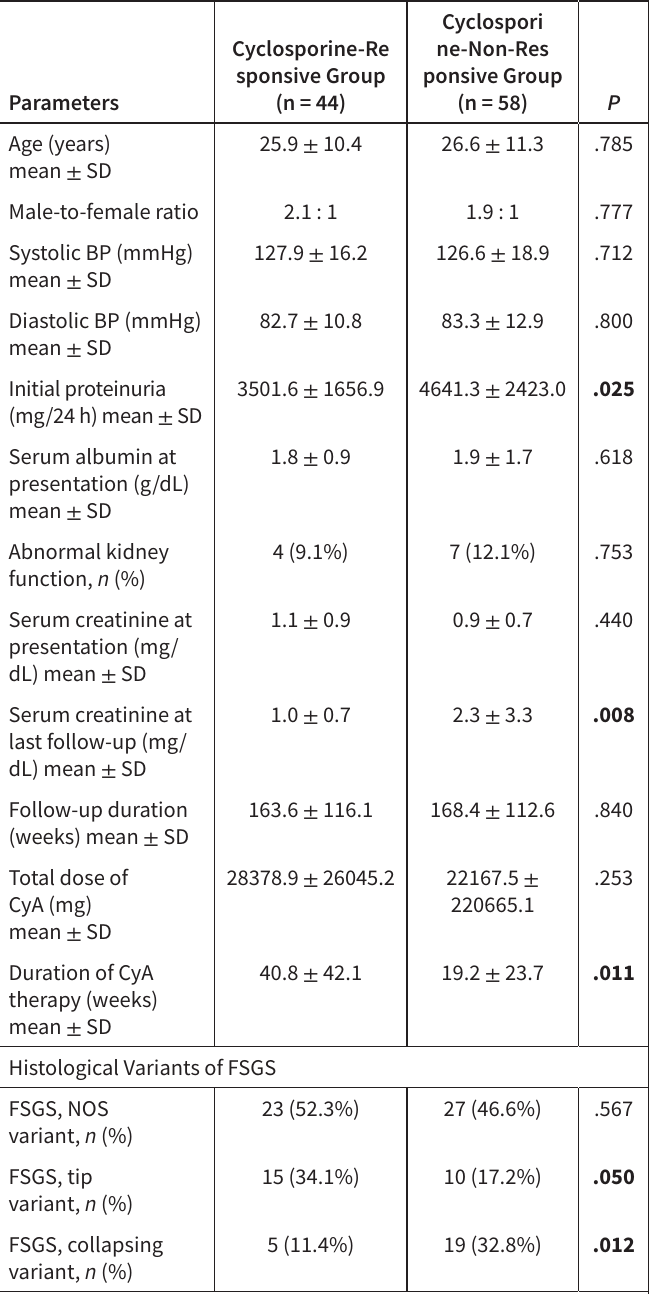
Table 4. Clinical Outcomes in Steroid-Dependent and Steroid-